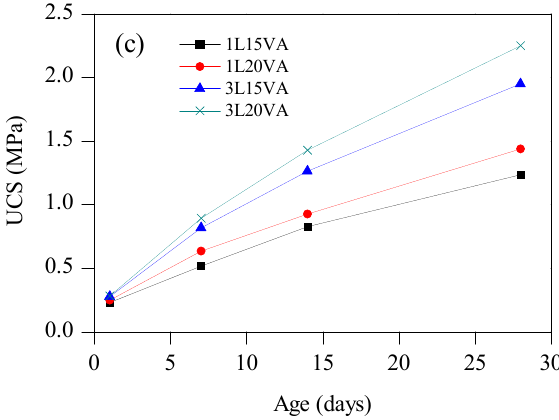
Figure 5. Influence of ( a ) lime, ( b ) VA, and ( c ) mixed stabilizer content on the UCS of BCS.